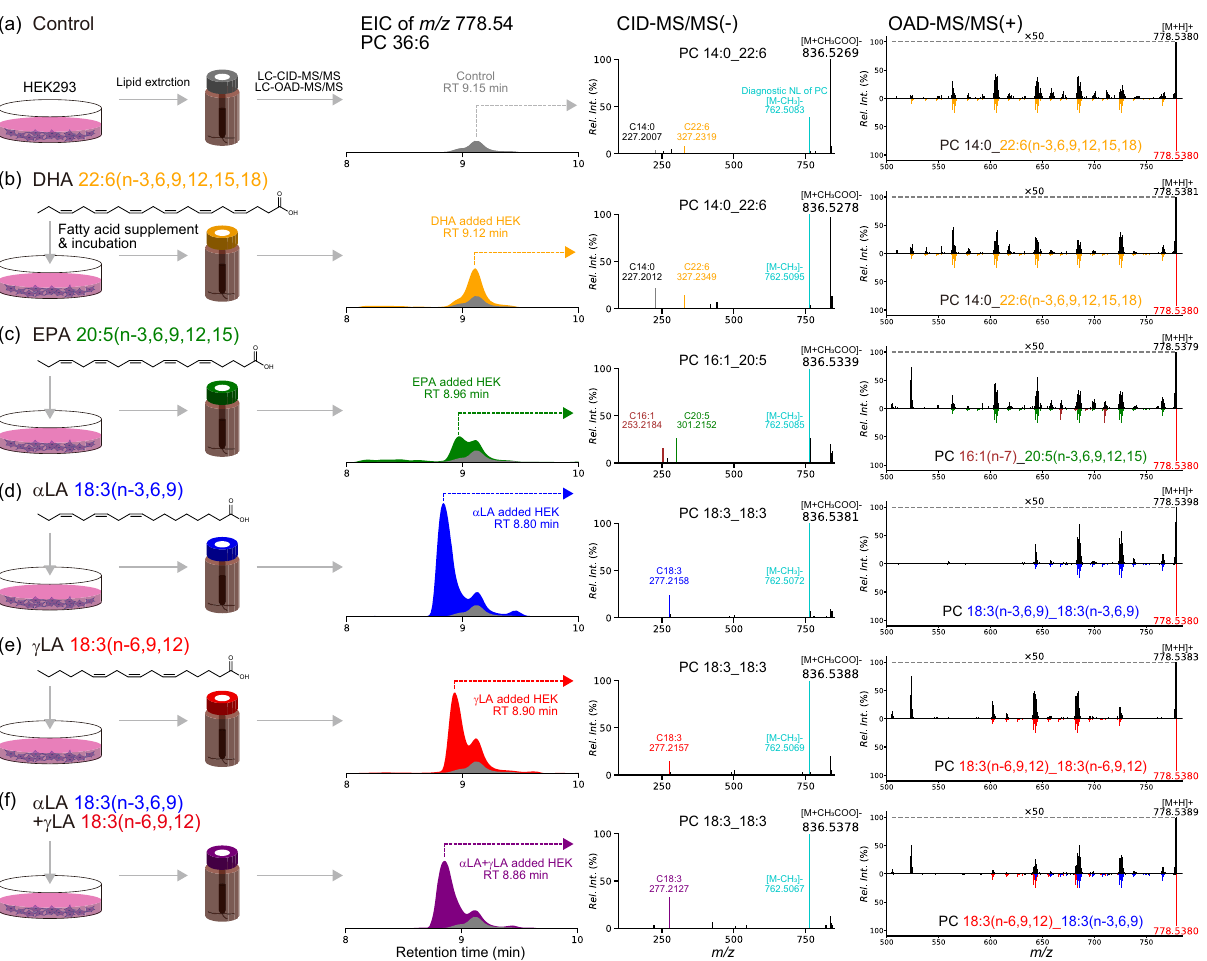
Fig. 3 Analysis of the lipid extract from the HEK293 cells fed with the polyunsaturated fatty acid (PUFA)-supplemented media. Extracted ion chromatography of m/z 778.54 of PC 36:6 and the corresponding CID-MS/MS and OAD-MS/MS obtained from the samples supplemented with ( a ) no PUFA, ( b ) docosahexaenoic acid (DHA), ( c ) eicosapentaenoic acid (EPA), ( d ) alpha-linoleic acid ( α -LA), ( e ) γ -LA, and ( f ) α -LA and γ -LA, respectively are shown in each row. The CID-MS/MS and OAD-MS/MS spectra were annotated by MS-DIAL and MS-RIDD programs. In the reversible spectral charts of OAD-MS/MS, the top and bottom panels show the experimental and reference MS/MS spectra,